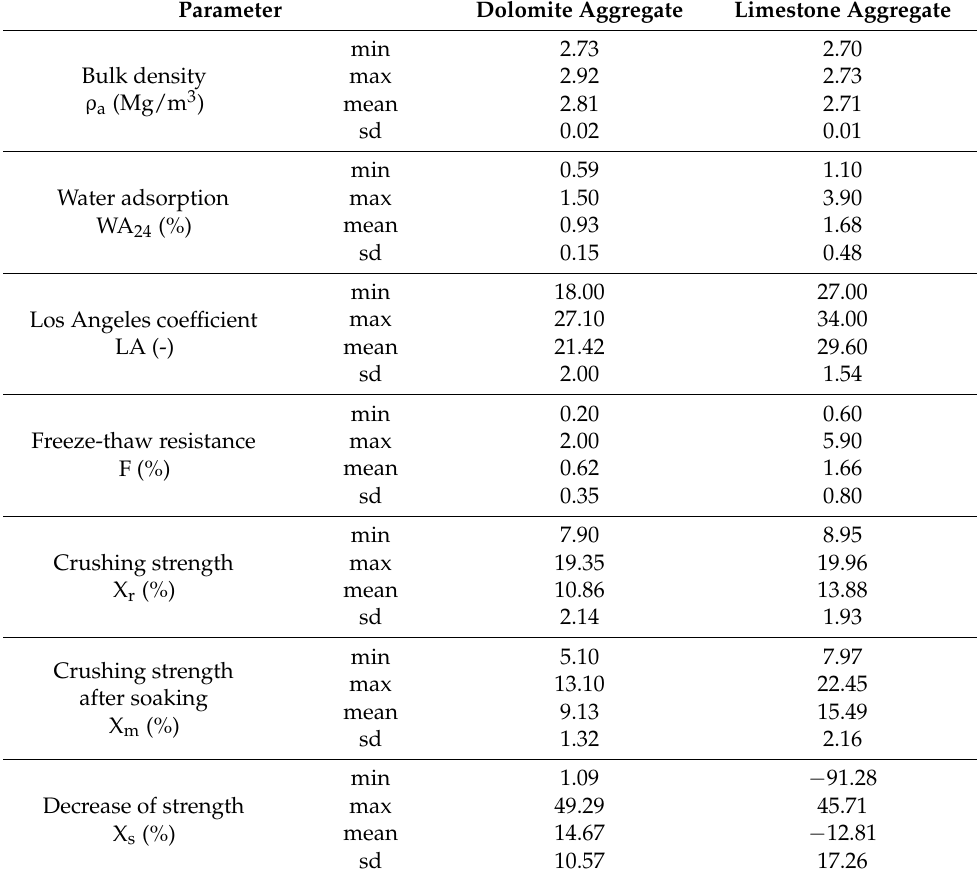
Table 1. Geotechnical parameters of dolomite and limestone aggregates. Statistic data: min—minimal value; max—maximum value; mean—average value; sd—standard